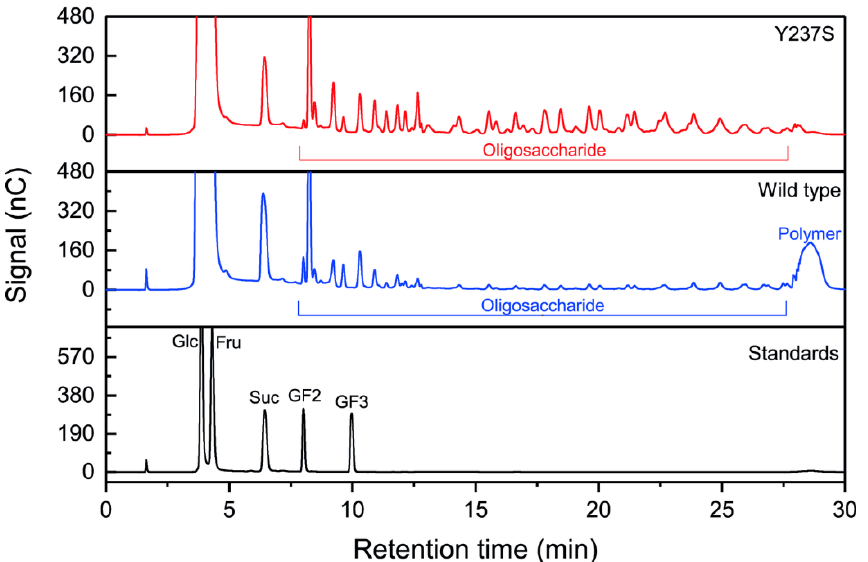
Figure 6. HPAEC chromatogram of wild-type and Y237S variant LsKK9. Biomolecules 2020 , 10 , x 10 of 15